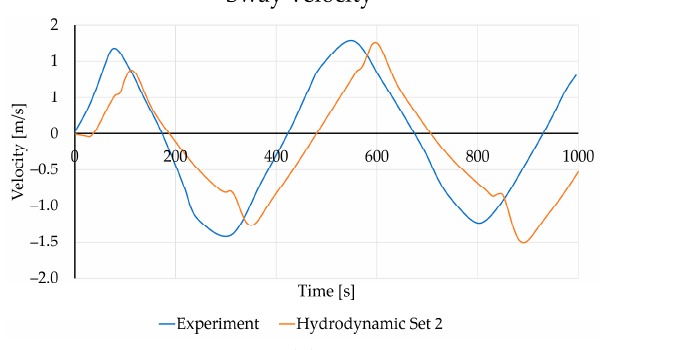
Figure 10. Turning circle test: ( a ) Surge velocity, ( b ) Sway velocity.